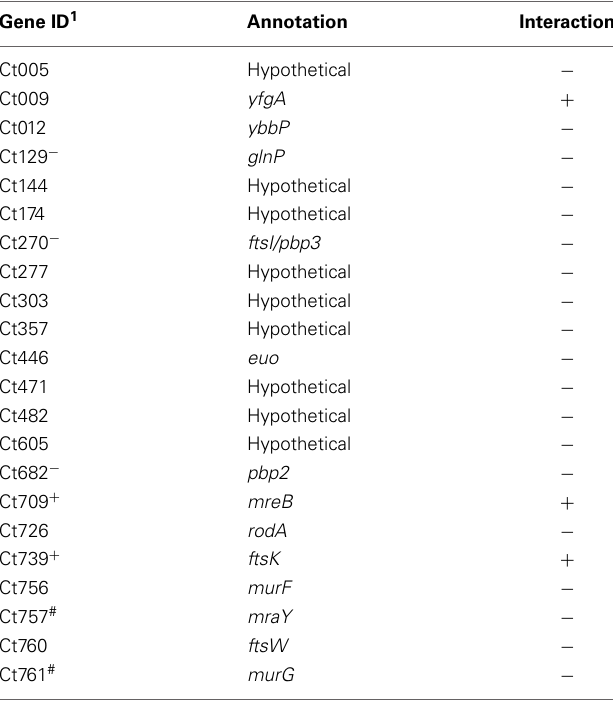
Table 1 | Small-scale BACTH screen to identify proteins that interact with chlamydial